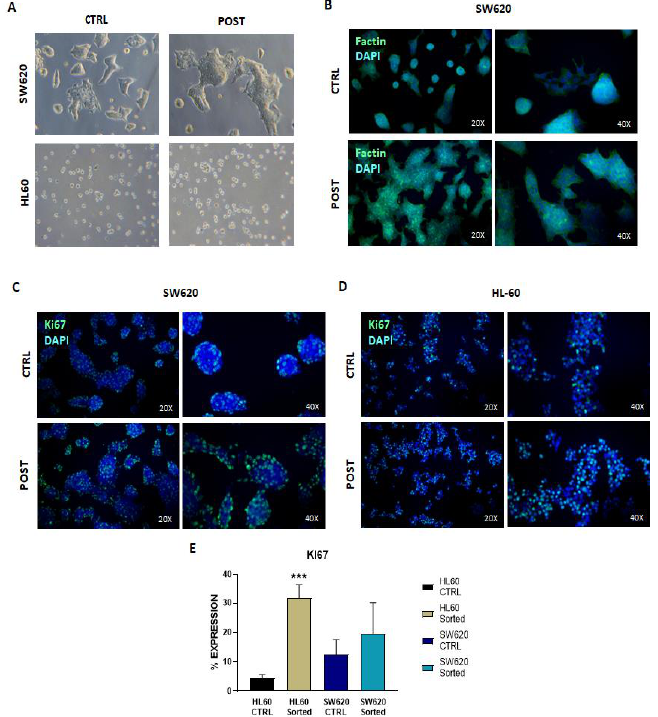
Figure 4. Representative images of HL60 and SW620 cells by light microscope ( A ) and expression of F-actin ( B ) in SW620 cells by immunofluorescence did not show any alteration in the cytoskeleton of selected cells. The proliferative characteristics of cells were analyzed by immunofluorescence staining for Ki67 ( C , D ) and quantified by Image J post-processing analysis by measuring the per- centage of the stained area ( E ). Statistical analysis was performed using the 2way ANOVA test and mean and standard deviation were graphed (*** p < 0.001).